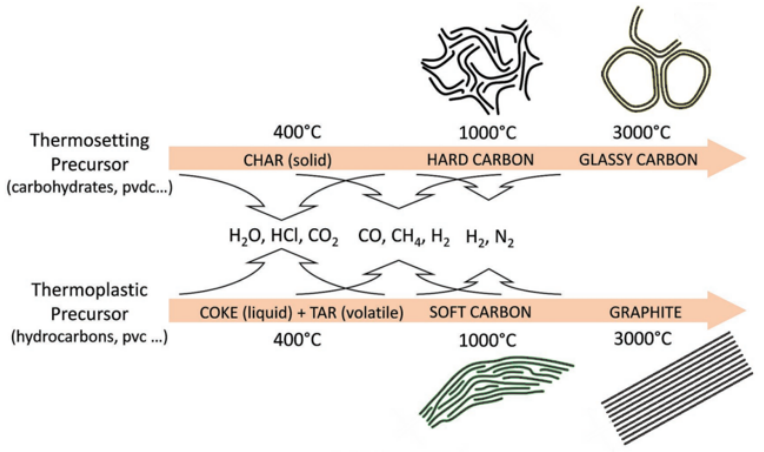
Figure 2. Schematic representation of the carbonization process during the pyrolysis of thermoset- ting and thermoplastic organic precursors [55]. and thermoplastic organic precursors